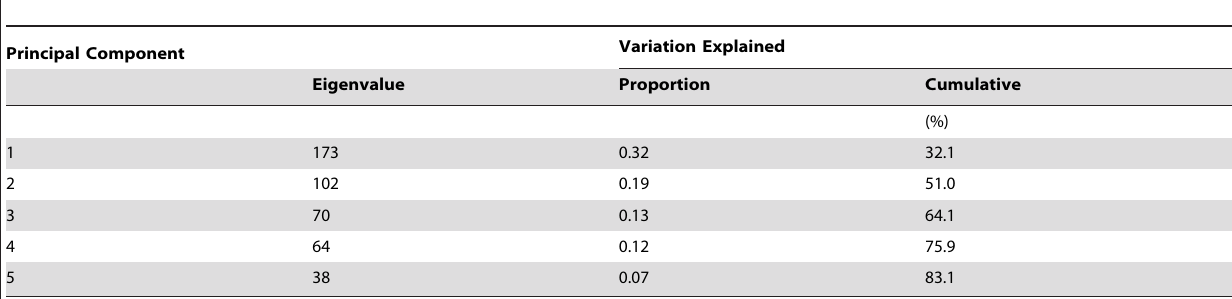
Table 4. Results from principal component analysis of GC/MS metabolomic data of frozen and Nonfrozen oat crowns during days 0 to 14 of